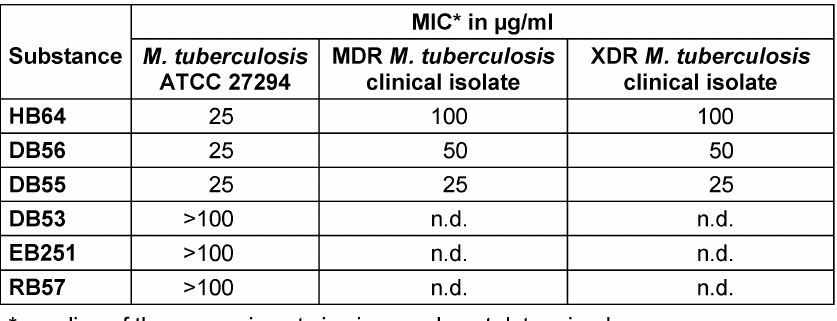
Table 1: Anti-tubercular activity of stilbenes